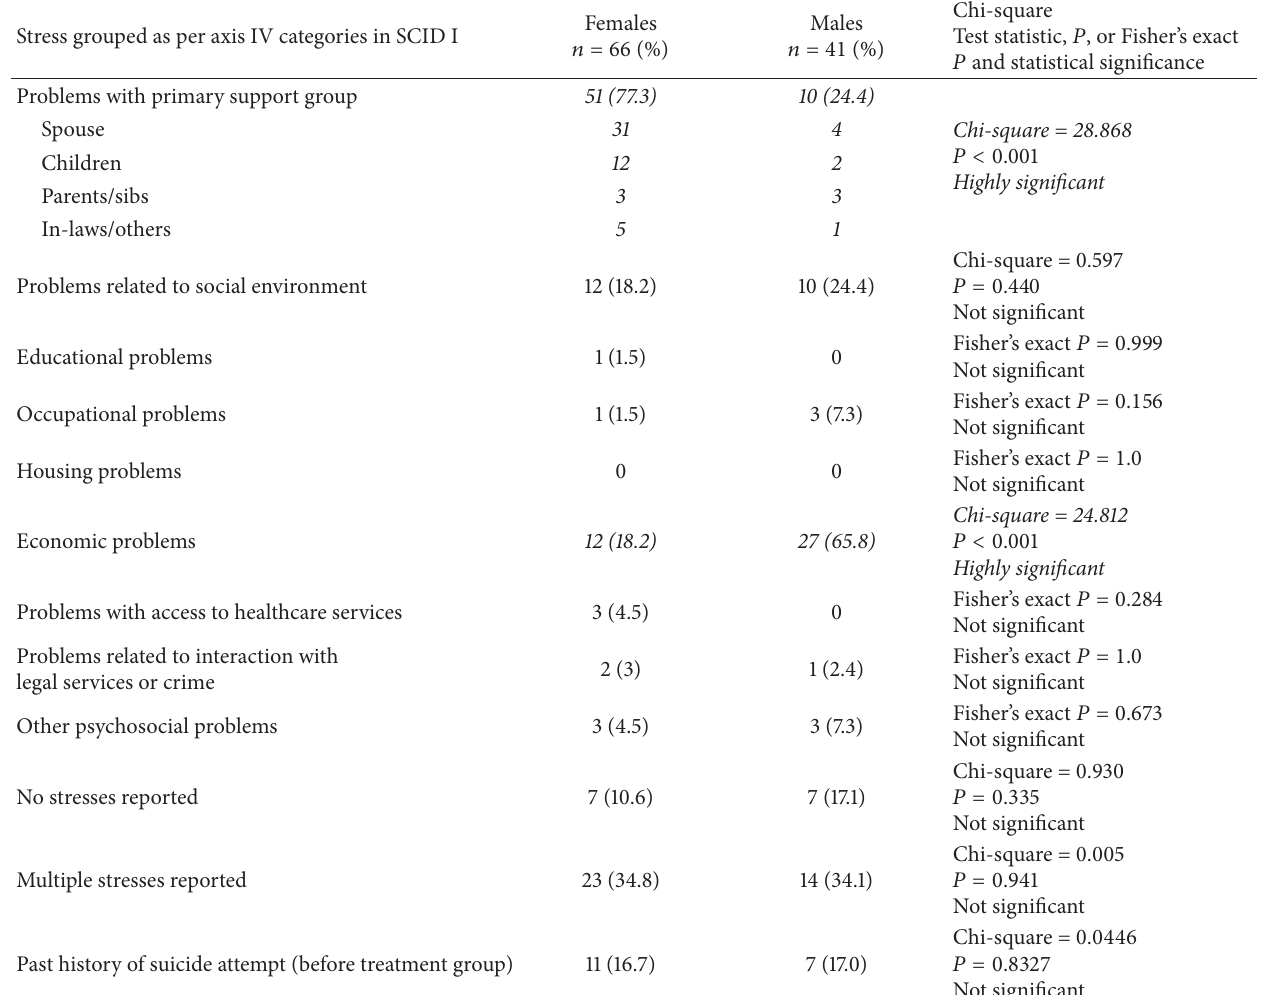
Table 3: Various stresses reported by male and female patients with MDD categorized as per axis IV from SCID I. Stress grouped as per axis IV categories in SCID I